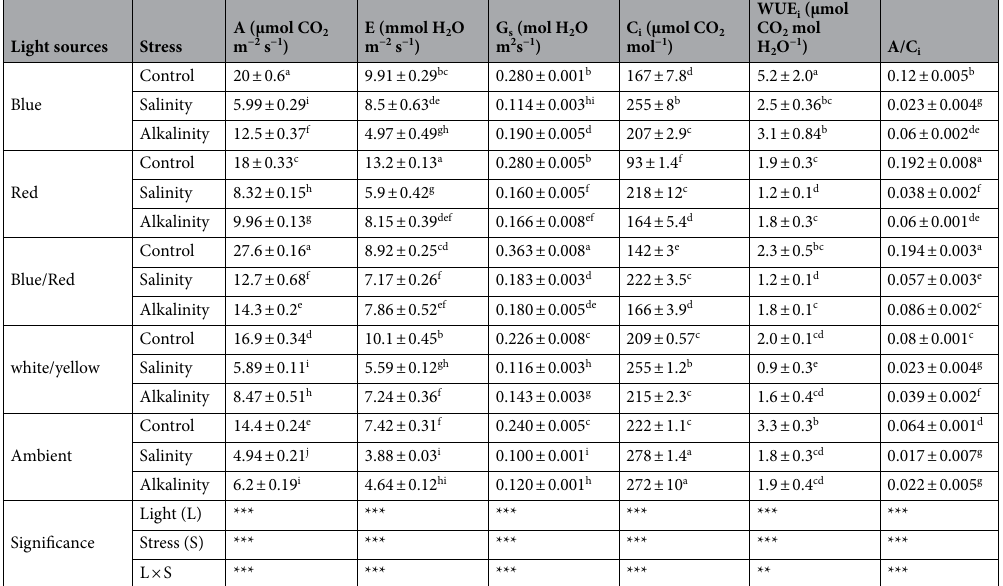
Table 2. Effect of light spectra and stress on leaf gas exchange parameters of strawberry cv. Paros. Values are means ± SE of three replicates. Bars with different letters show significant differences at P ≤ 0.05 (LSD). Significance according to ANOVA, ns, * , ** , ** * , nonsignificant and significant P ≤ 0.05, 0.01, 0.001, respectively. Control (non-stress), salinity (80 mM NaCl) and alkalinity (40 mM NaHCO3). Photon flux density for the complement spectrum (PPFD) 200 ± 10 mmol m –2 s –1 . SAS software version 9.4 was used